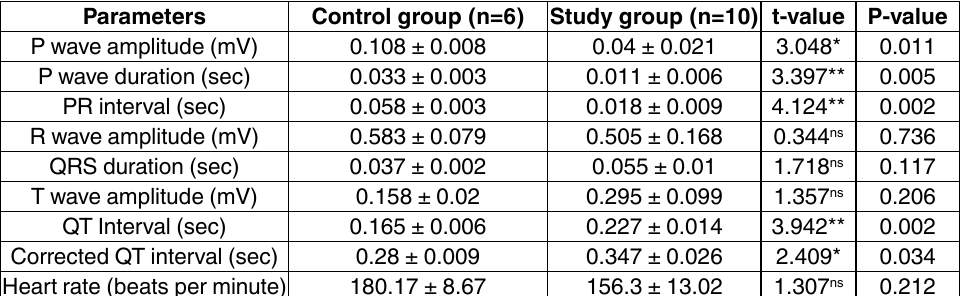
table 3. Comparison of values of ECG of lead II between control and study groups in case of hyperkalaemia